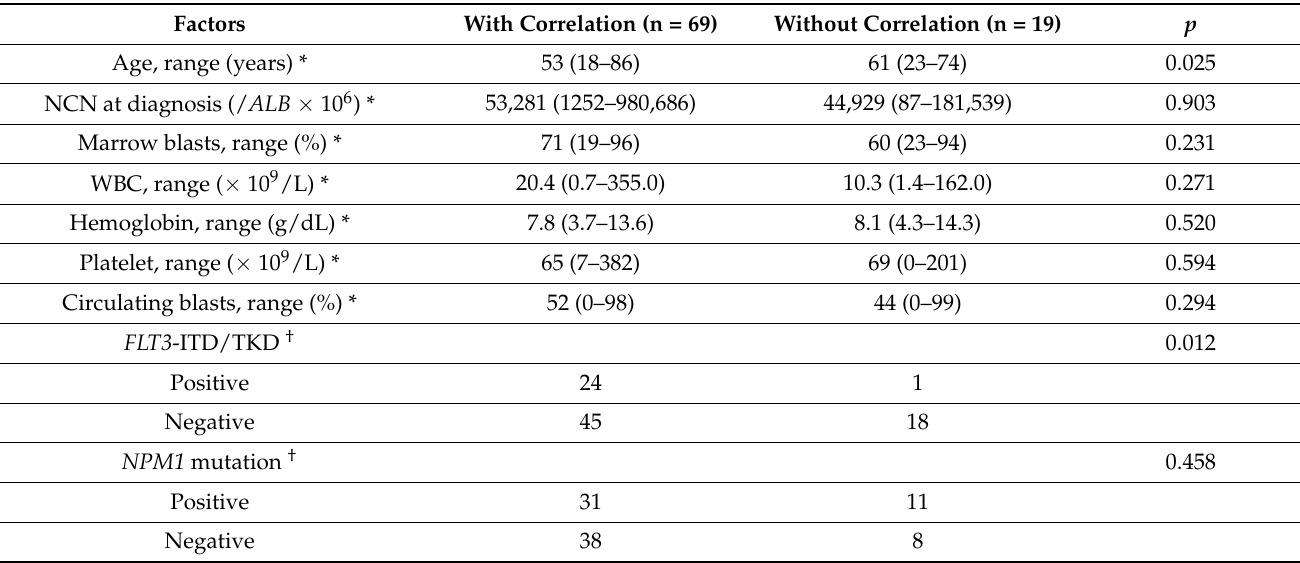
Table 3. Clinical characteristics and the correlation between IDH1/2 qPCR MRD and hematologic remission status.